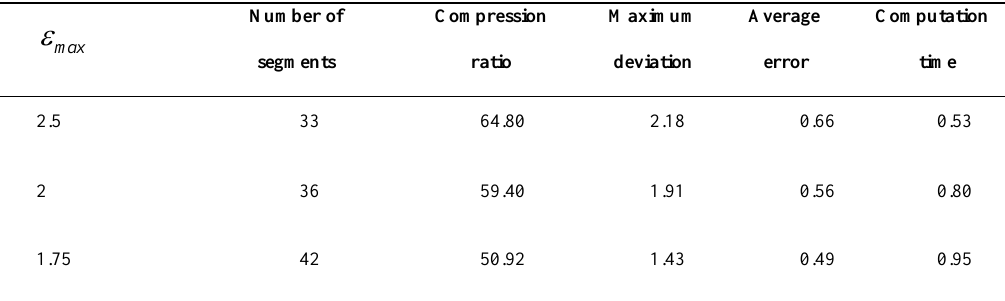
Table 2. Performance of the proposed algorithm for the shape Kanji